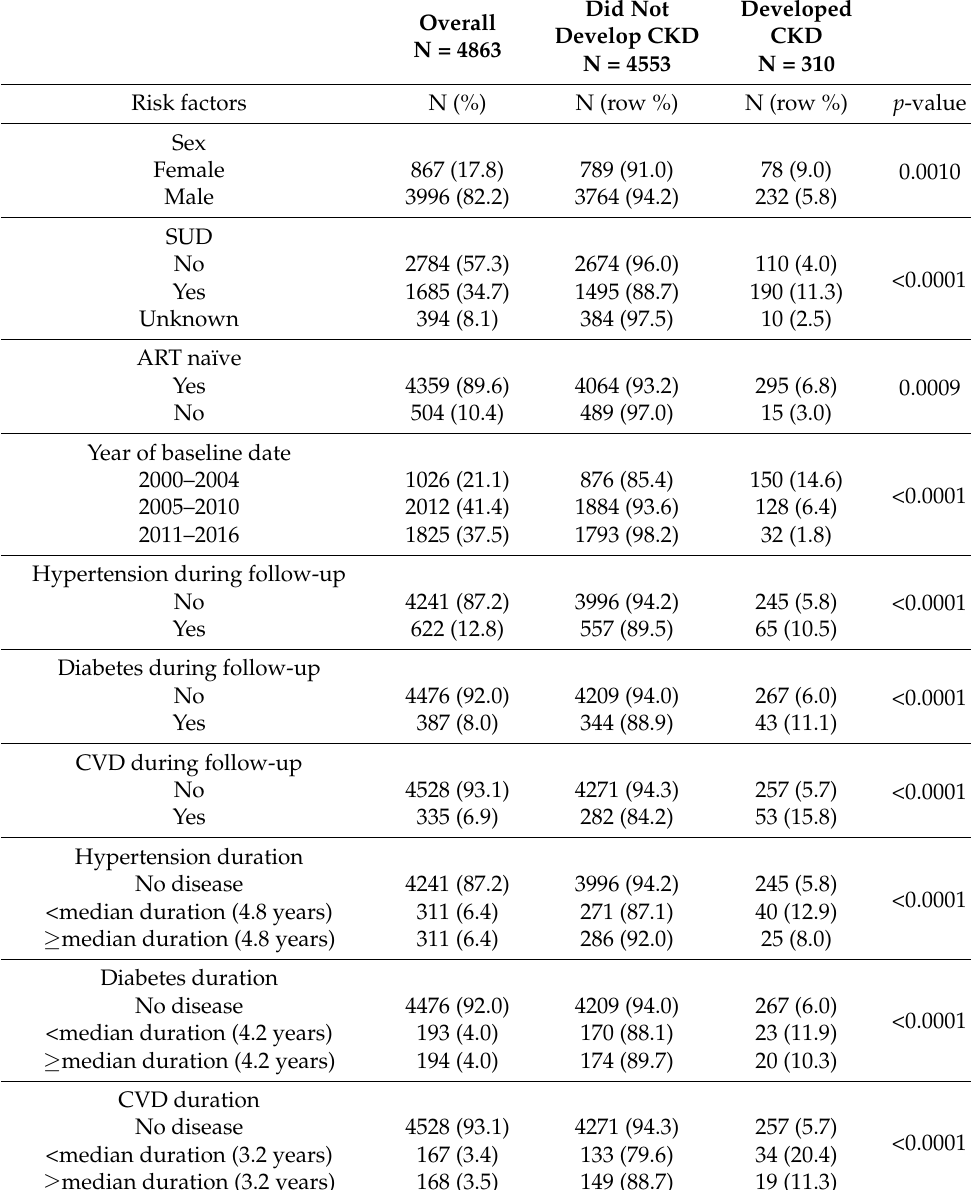
Table S2. Most of the included participants were male (82.2%), ART naïve (89.6%), without a history of SUD (57.3%), hypertension (87.2%), diabetes mellitus (92.0%), and CVD (93.1%). The median follow-up time was 6.45 (25th, 75th percentiles: 3.57, 9.89) years, and the median number of CD4:CD8 measurements was 8 (25th, 75th percentiles: 4, 15). A total of 310 (6.4%) participants developed CKD throughout the study. Bivariable analyses revealed that participants who developed CKD and those who did not differ across all measured characteristics, except age at the end of follow-up, and the proportion of time on NNRTI Table 1. Participants who developed CKD were more likely to be female, naïve to ART, enrolled in the cohort between 2000 and 2004, with a history of SUD, hypertension, diabetes and CVD, older at study entry, higher baseline HIV viral load, shorter exposure to TDF, and longer exposure to PI. Table 1. Study population characteristics of the final analytical sample of eligible participants ( n = 4863), stratified by chronic kidney disease status.